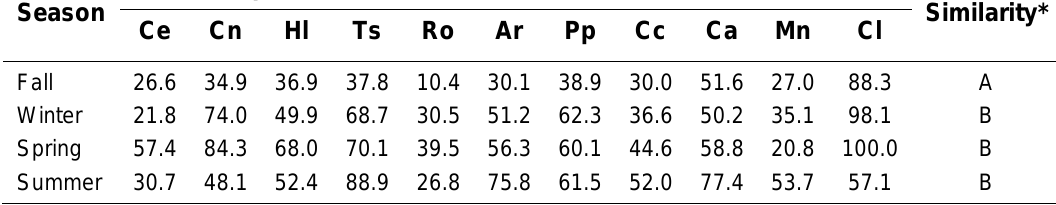
Between-Quarter Differences in the Proportional Contributions of Planktonic Energy Sources to 11 Consumer Species Assessed by Two-Way ANOVA Analyses